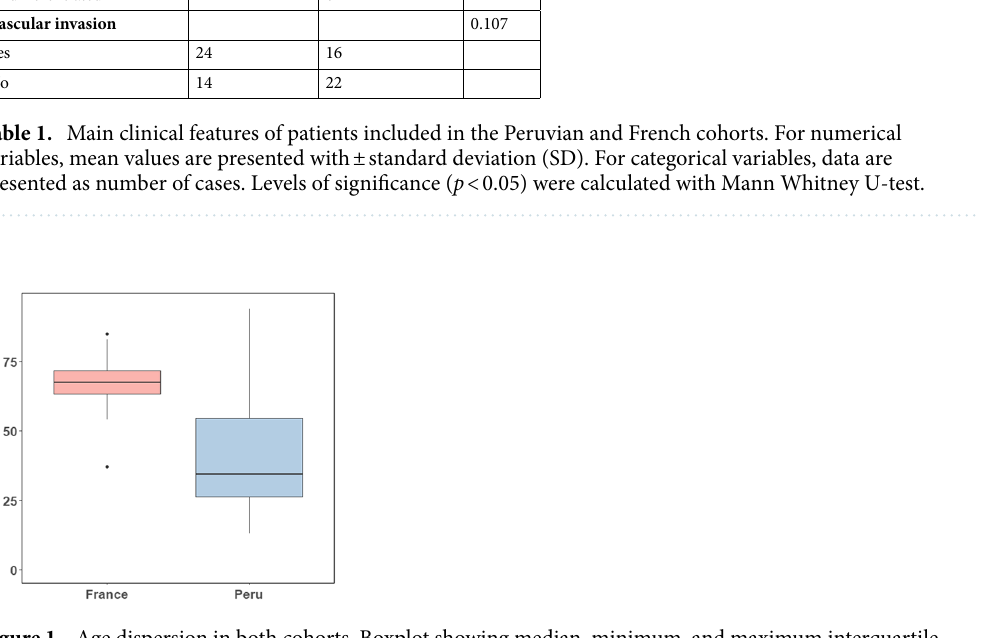
Figure 1. Age dispersion in both cohorts. Boxplot showing median, minimum, and maximum interquartile range (IQR) values for ages between Peruvian and French patients. Data were analyzed with Mann Whitney test (p <